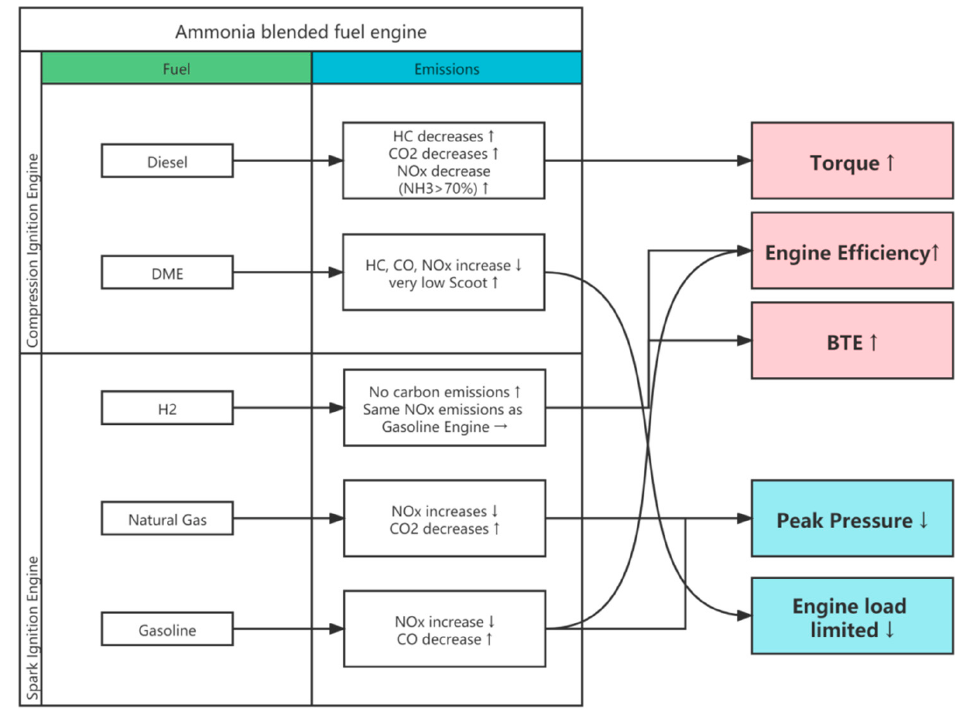
Figure 13. Summary of the effects of different blended fuels.